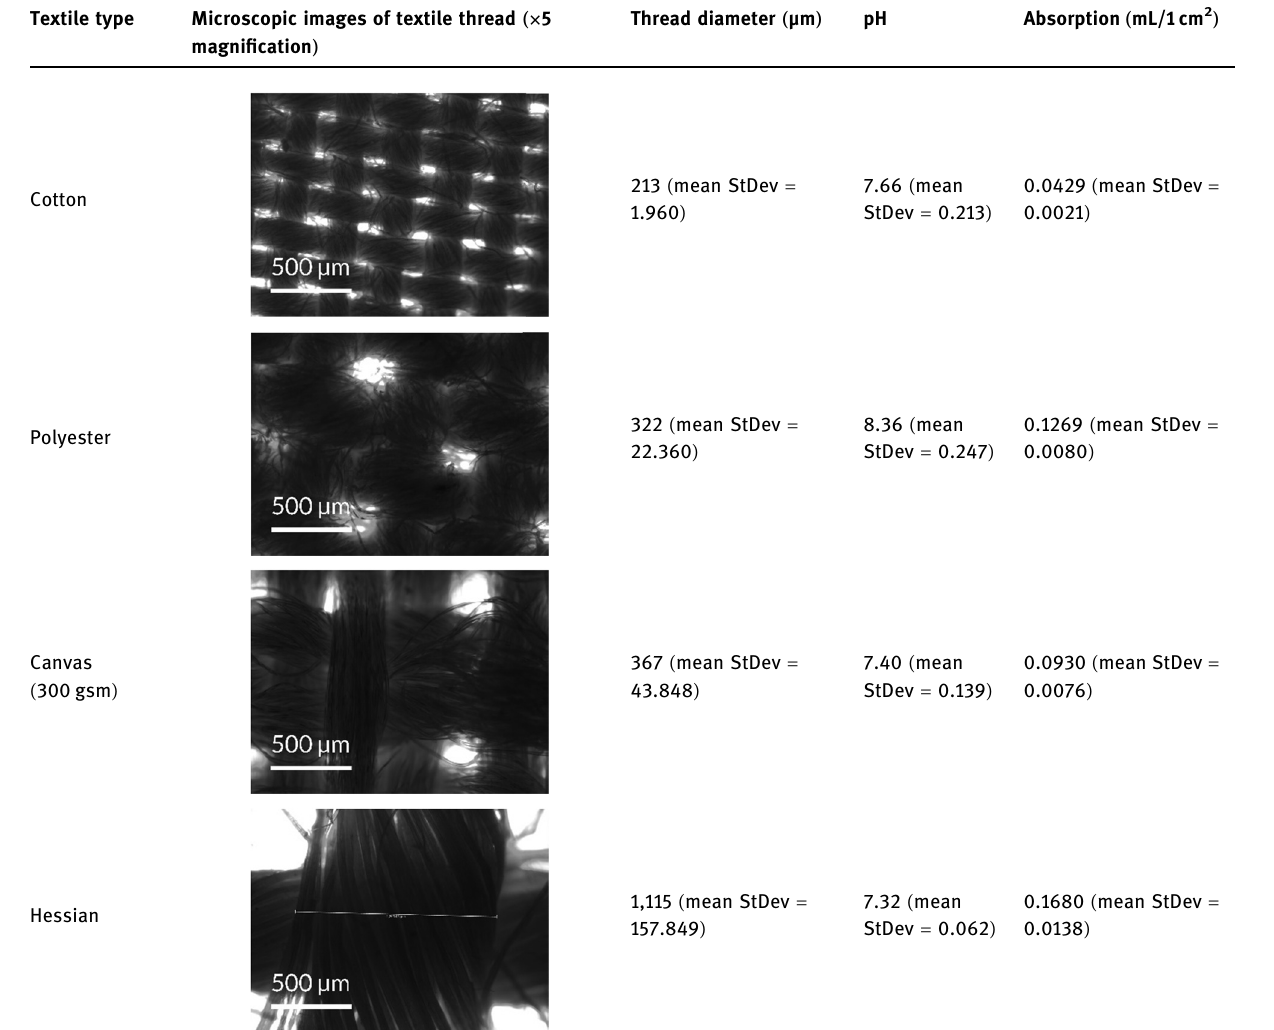
Table 5: List of textiles and material properties Textile